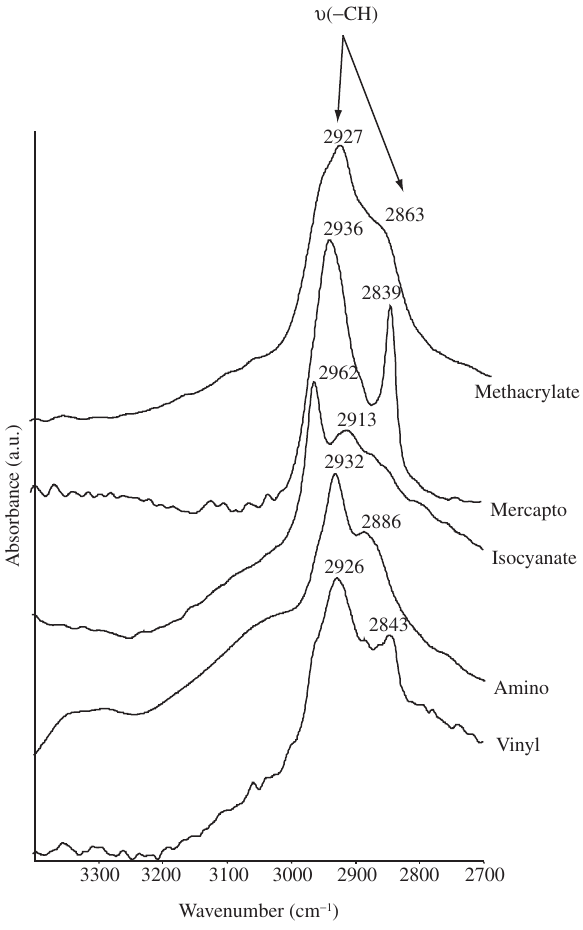
Figure 5. FTIR spectra for surface modified glass.